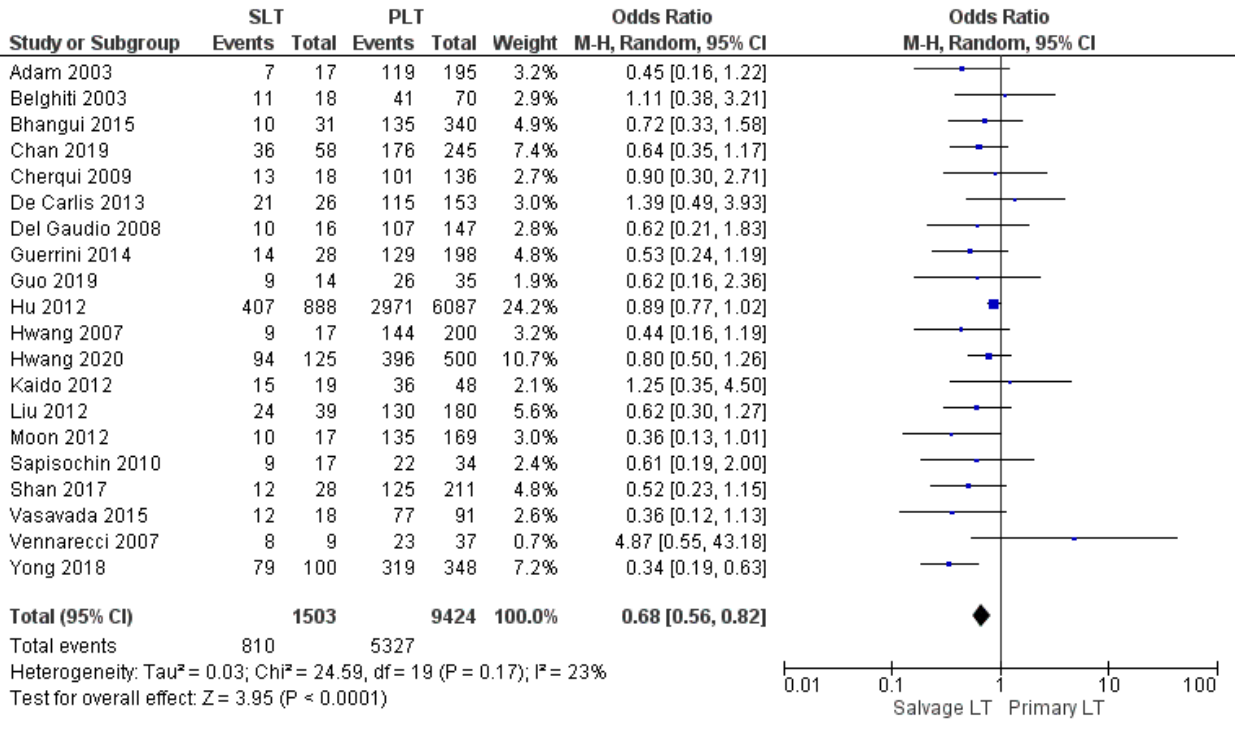
Figure 18. 5 - year overall survival rates.